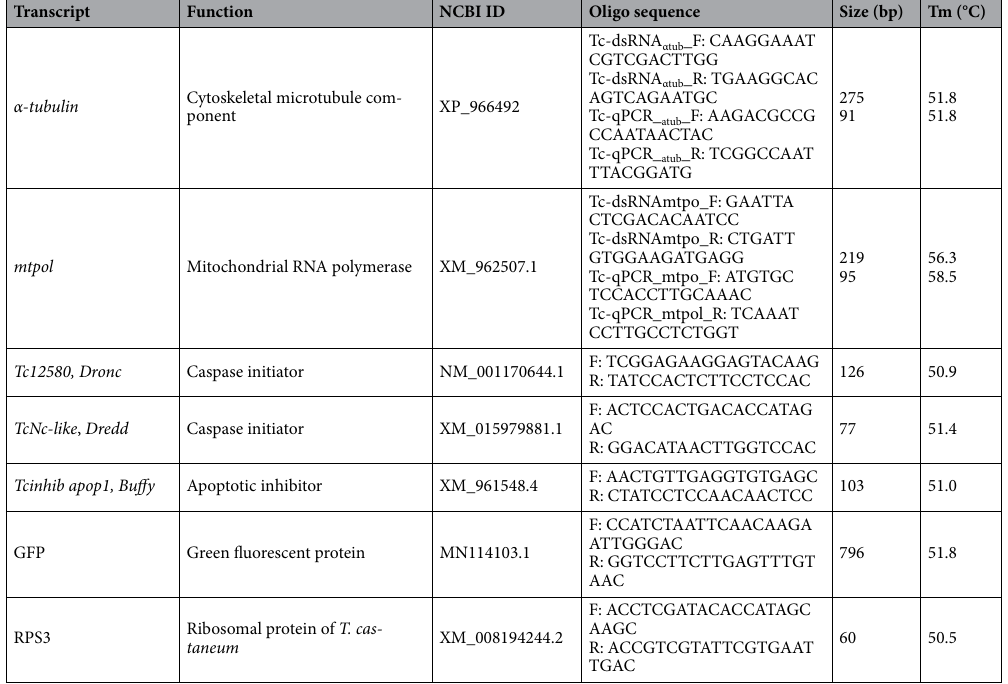
Table 1. Oligos for dsRNA preparation and target transcript evaluation. Tm is annealing temperature of